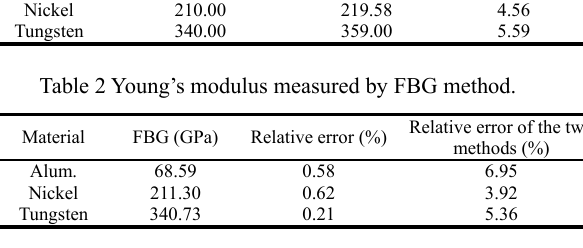
Table 1 Young’s modulus measured by CCD system. Material